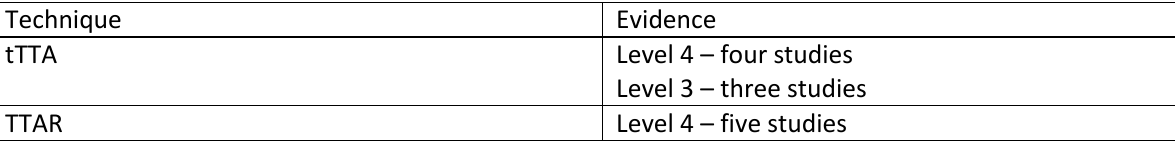
Table 1: A summary of the strength of evidence.